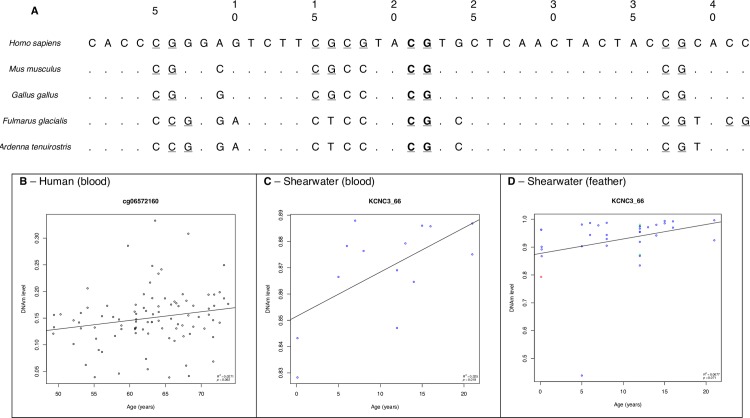
KCNC3 sequence conservation in mammals and select bird species.A: 20 base pairs are shown for 3’ and 5’ directions around an age related CpG loci (27K: cg06572160, in bold) in the KCNC3 gene in humans (KCNC4/2 in F. glacialis and G. gallus). Following the methods described in text, this sequence was compared to the mouse, chicken and northern fulmar genomes. Conserved bases are shown with a dot (.) and the base is given where there is a mismatch. Other CpG sites in the sequence are underlined and are shown in the bird sequences. In this example, 4 CpG loci in humans are conserved in chicken, whilst 1 is lost (pos. 17). However, in fulmar and shearwater, 3 CpG loci were conserved whilst the remaining 2 in humans were lost (pos. 15 and 17). A plot of the age relationship observed in human blood, Fig 4B at cg06572160 (Rakyan et al. 2010). DNAm results for the same CpG site in shearwater is shown for shearwater blood, Fig 4C and shearwater feather, Fig 4D. A technical replicate is shown in red whilst a run replicate is shown in green for D.